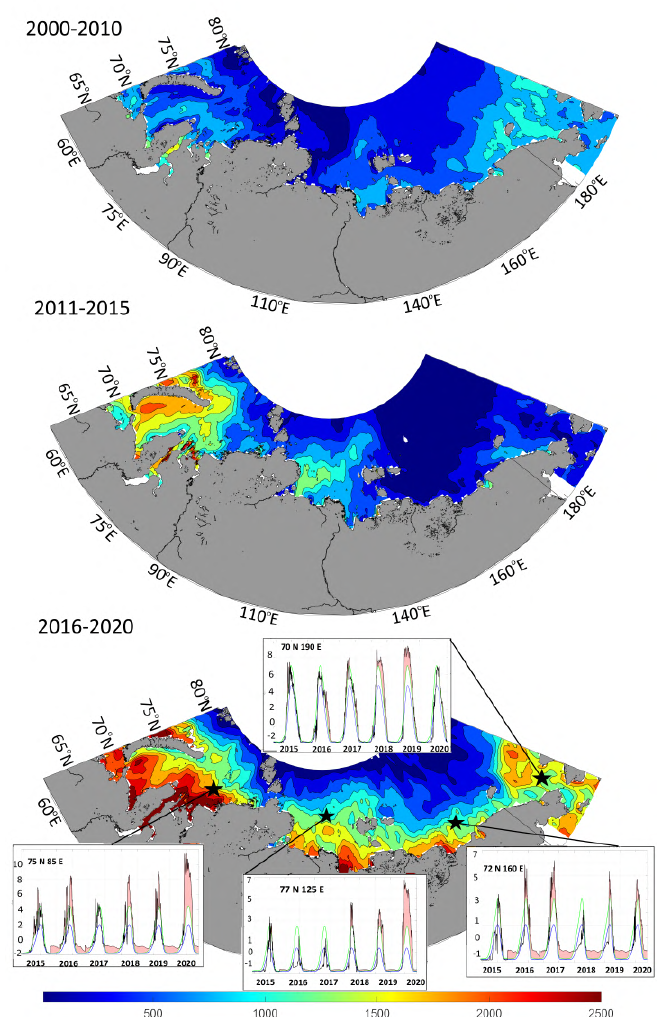
Figure 2. Intensity composite index ICI ( ◦ C · days) for the Siberian Arctic seas in 2000–2010, 2011–2015 and 2016–2020, based on original data series. Temperature time series (black line) in the selected points (black stars) illustrate marine heatwaves, marked as pink shading between black and green lines. Blue line shows baseline temperature climatology and green line—threshold values defined based on the 90th percentile value for each day of the